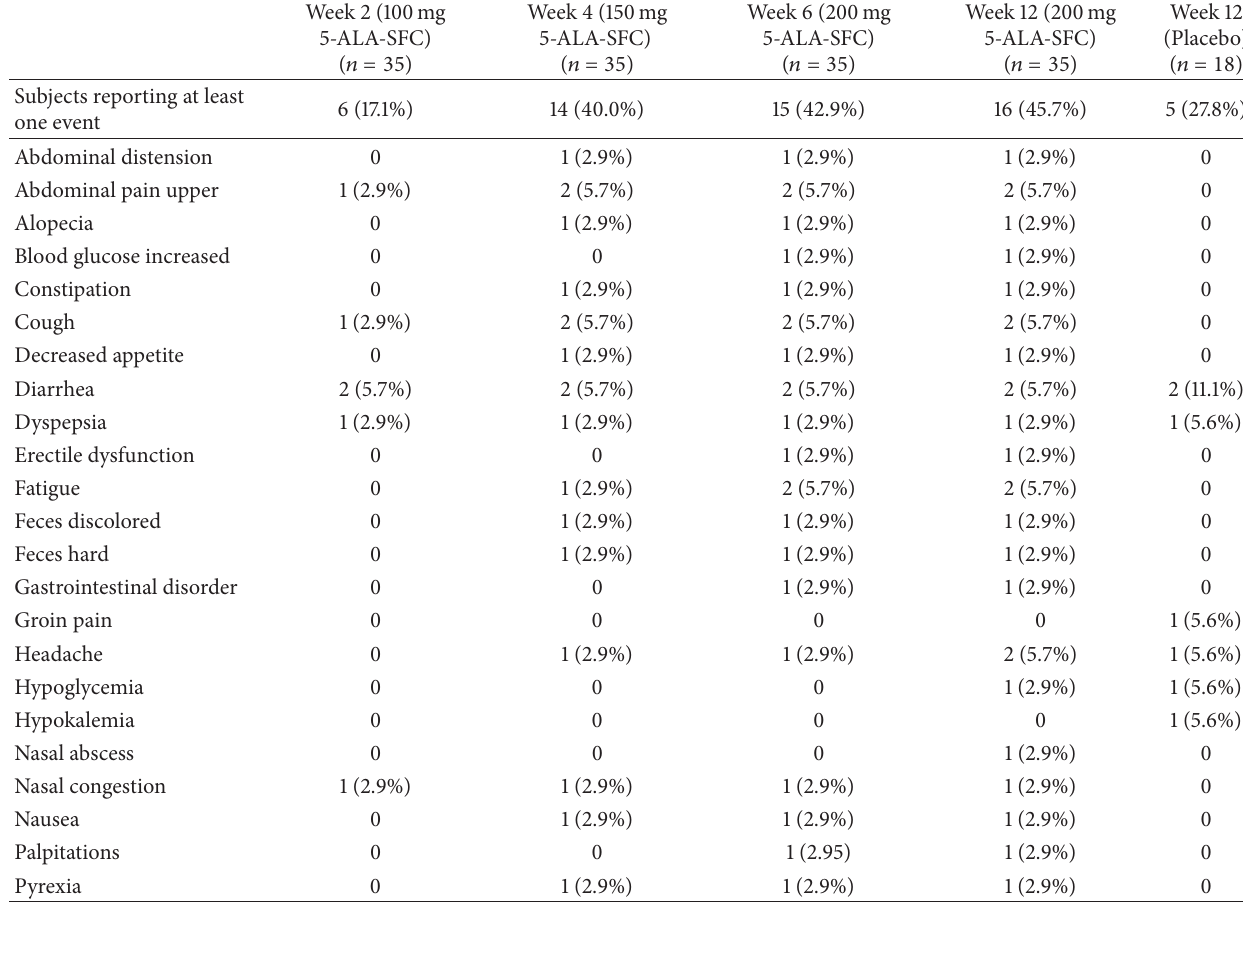
Table 3: Cumulative summary of treatment emergent adverse events over time.